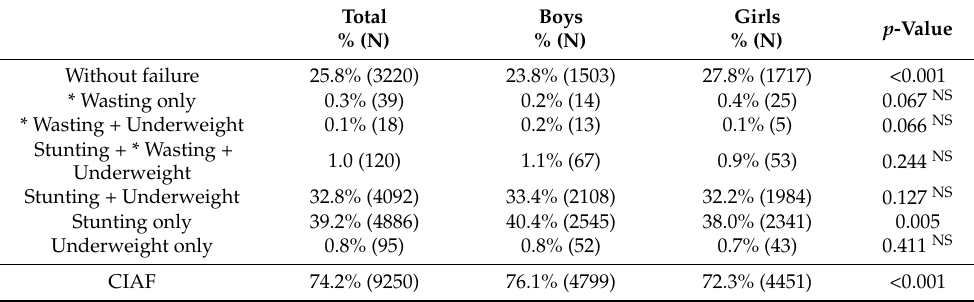
Table 2. Composite Index of Anthropometric Failure (CIAF) compared by sex.